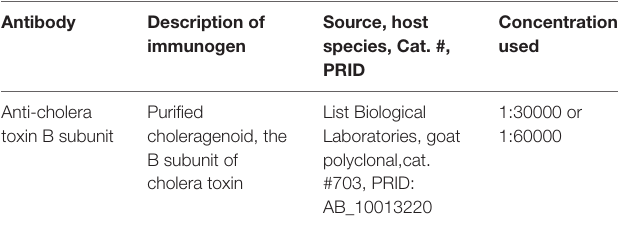
TABLE 2 | Primary antibody used in this study. Antibody Description of immunogen